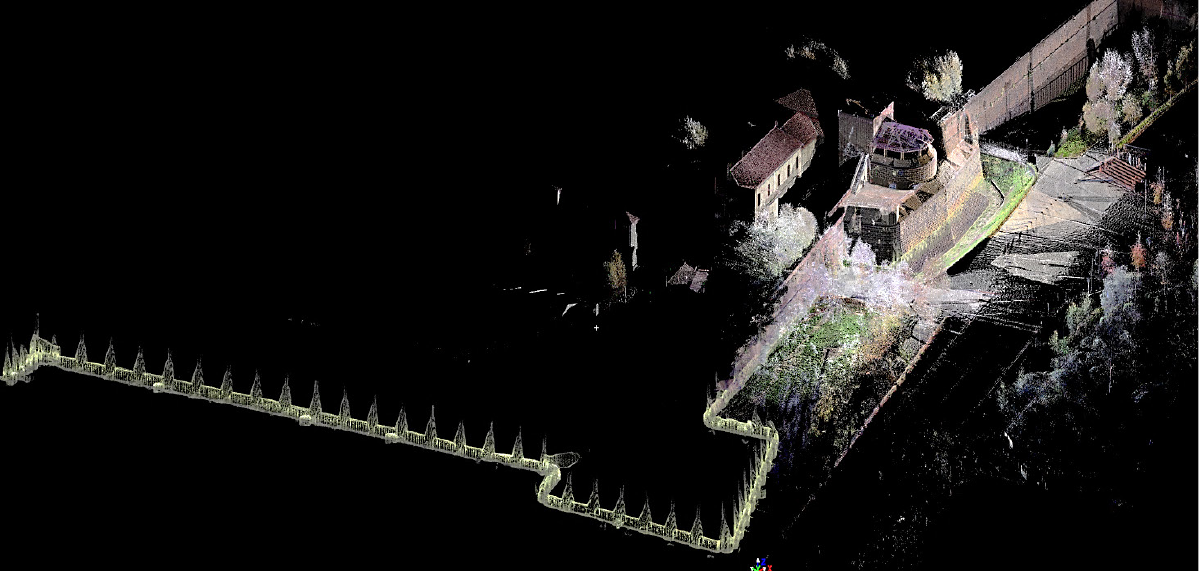
Figure 5. The entrance of the fortress and the underground passageways acquired by